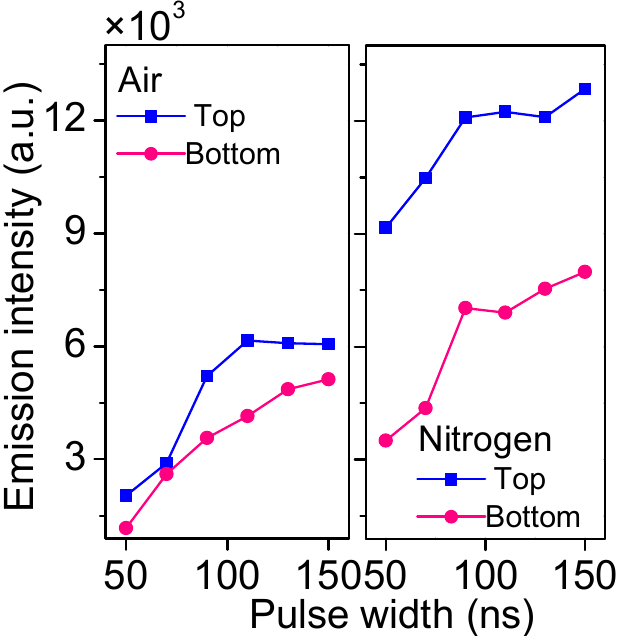
Figure 11. Effects of pulse duration on emission intensity of SPS of N 2 collected from the top and bottom of the reactor under air and nitrogen.